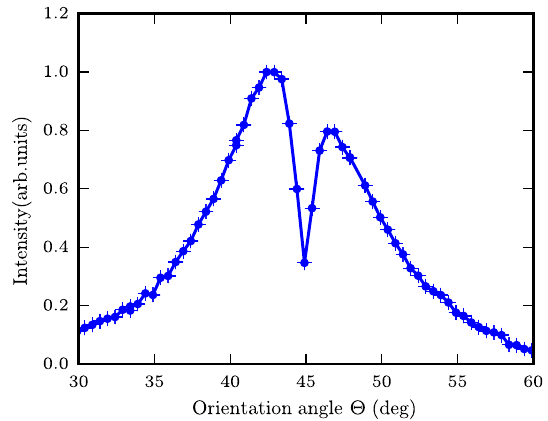
FIG. 5. SPR spectral measurements results. a and b are interferograms measured in the range of 60 – 90 GHz and 320 – 460 GHz, respectively. Bottom plots: reconstructed